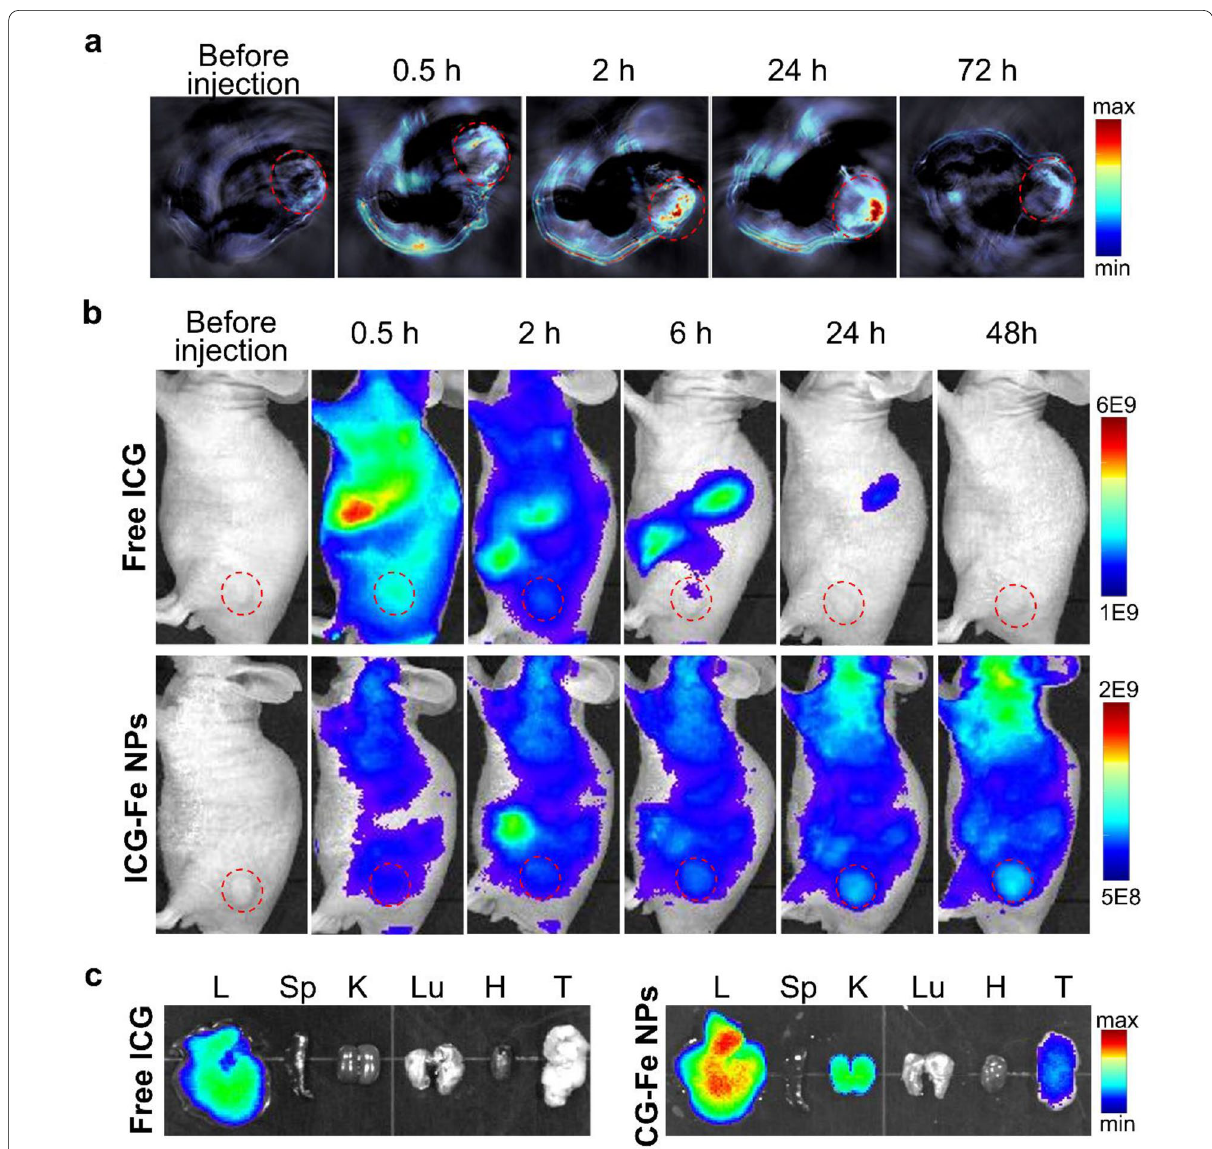
Fig. 6 In vivo dual‑modal imaging. a Cross‑sectional PA images of the HT‑29 tumor xenograft in a mouse model after intravenous injection of ICG‑Fe NPs ([ICG] 3.75 mg/kg). b In vivo and c ex vivo fluorescence images of a HT‑29 tumor‑bearing mouse after intravenous injection of free ICG = and ICG‑Fe NPs. Excitation (740/30 nm) and emission (790/20 nm) filters were used for fluorescence imaging. The red dotted circles in b indicate the tumor region. Tumors and other organs were collected 24 h post injection: L: liver, Sp: spleen, K: kidney, Lu: lung, H: heart, T: